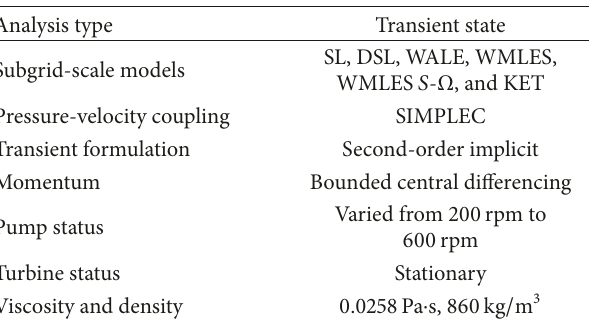
Table 2: CFD model